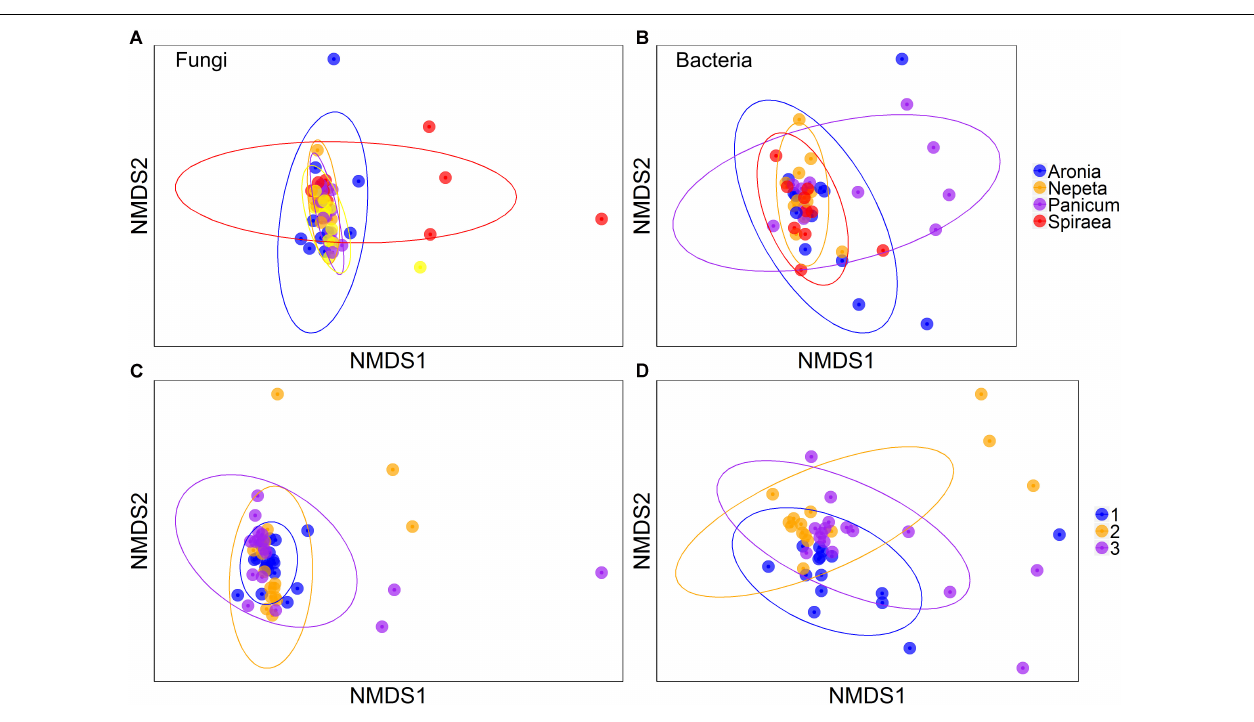
FIGURE 2 | Non-metric multidimensional scaling of fungi across plant species (A) and bioswale (C) and also of bacteria across plant species (B) and bioswale (D) . Figure represents dissimilarity as the Bray–Curtis metric and the ellipses signify 95% confidence